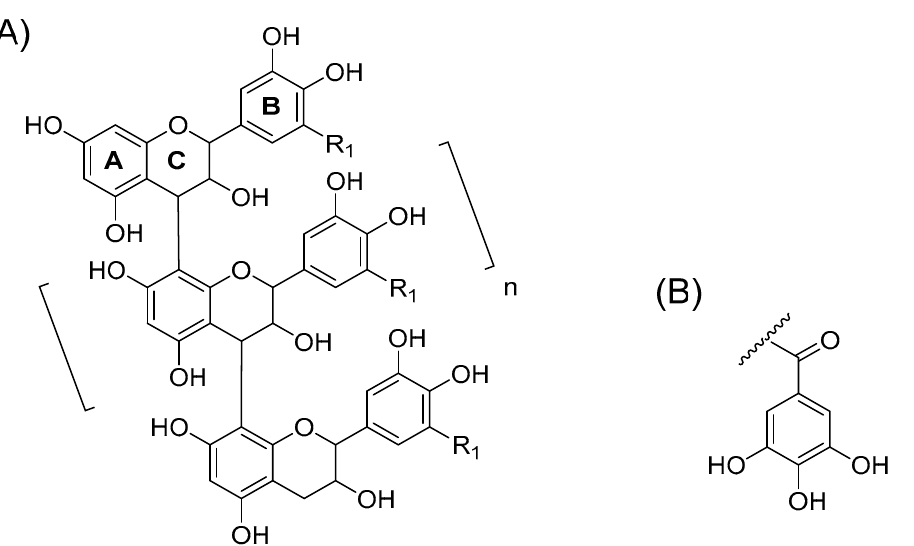
Figure 1. ( A ) A model structure for oligomeric B-type proanthocyanidins (PAs) with C4 → C8 linkages: R 1 = H, procyanidin, R 1 = OH, prodelphinidin. B-type PAs can also be linked by C4 → C6 bonds. A-type PAs have an additional C2 → O → C7 or C2 → O → C5 ether bond. The hydroxyl groups can also be substituted, for example, galloylated or glycosylated. ( B ) A galloyl group. The chemical properties of PAs can be modified through derivatization reactions